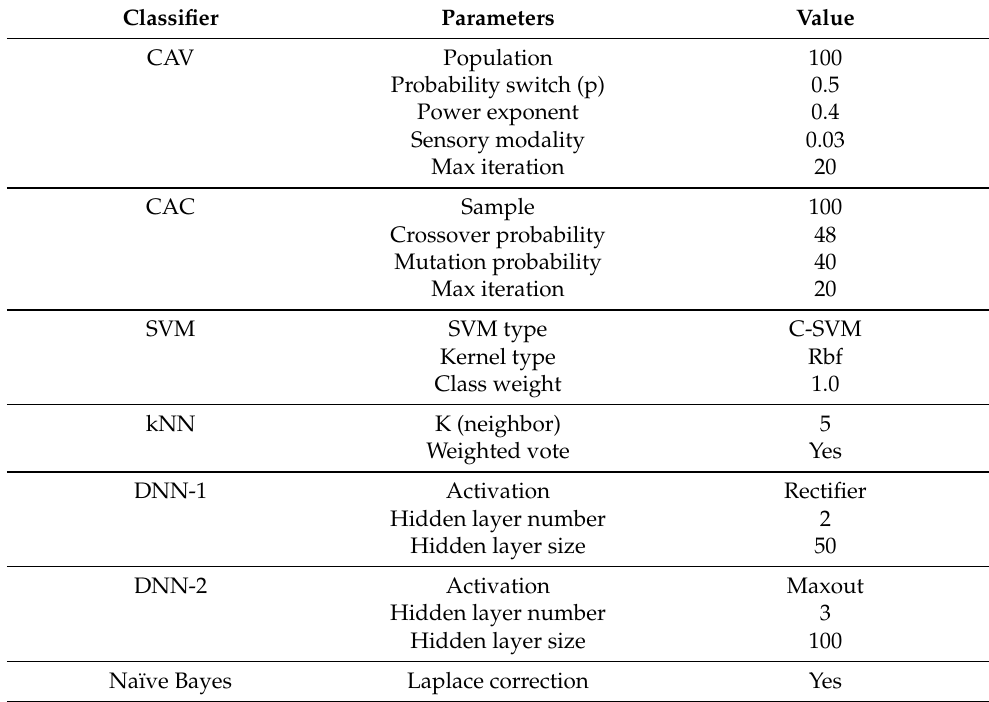
Table 2. Classification method